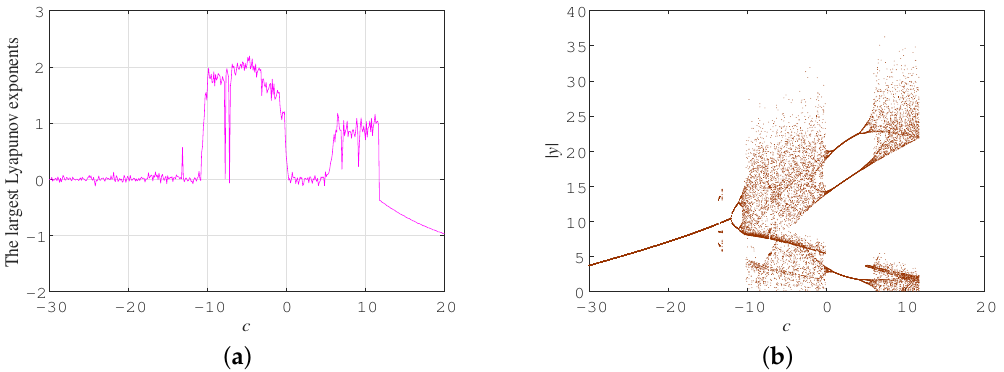
Figure 9. Parameter values ( a , b , k ) = ( 10,100, − 0.2 ) , largest Lyapunov exponent spectrum ( a ) and bifurcation diagram ( b ) of system (1) for c ∈ [ − 30,20 ] .